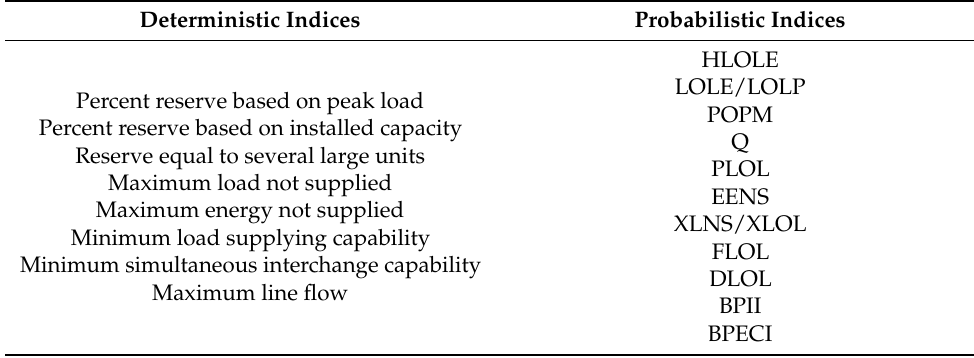
Table 3. Various Reliability Indices in Power